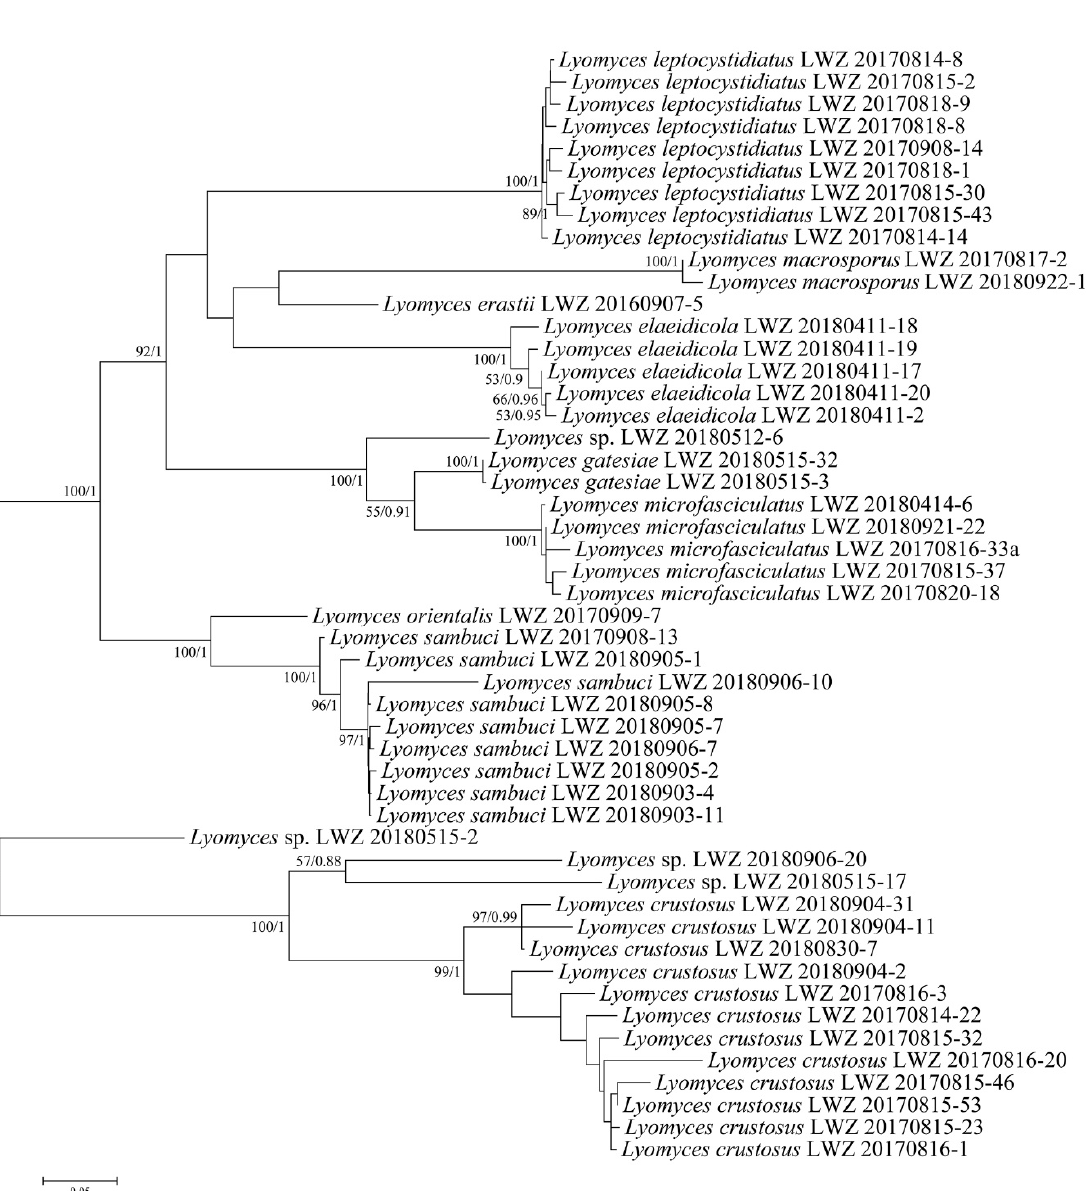
Figure 4. Phylogenetic relationship among species of Lyomyces inferred from the combined dataset of ITS, nLSU, mt-SSU, tef1 α , rpb1 , rpb2 and atp6 regions. The topology generated by the maximum likelihood algorithm is presented along with the bootstrap values and the Bayesian posterior probabilities above 50% and 0.8, respectively, at the nodes.